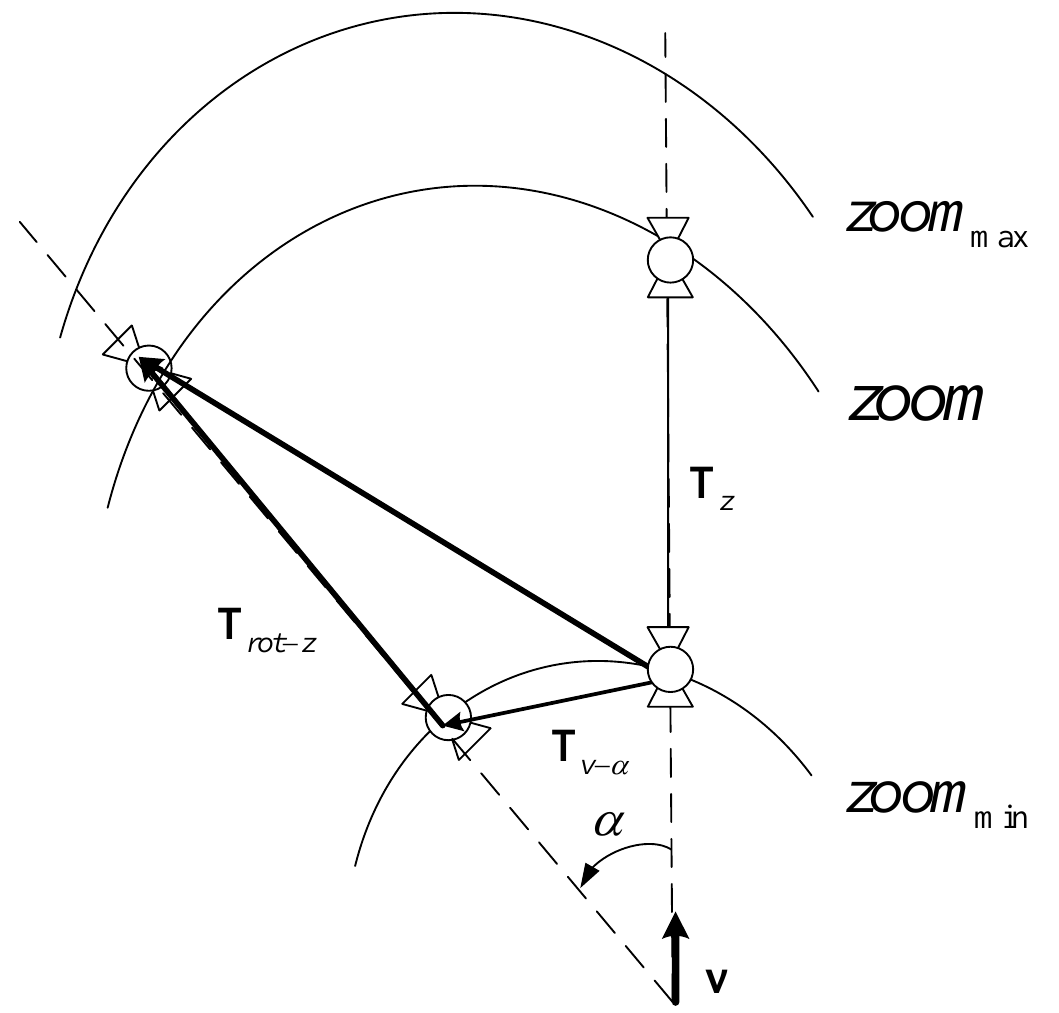
rotation radius of (cid:107) m (cid:107) on plane γ . The intersection of γ and the vector ( v ) is point c; the vector from the circle center, c, to the optical center in the camera’s initial coordinate system, − xyz , is the radius vector ( m ). O 1